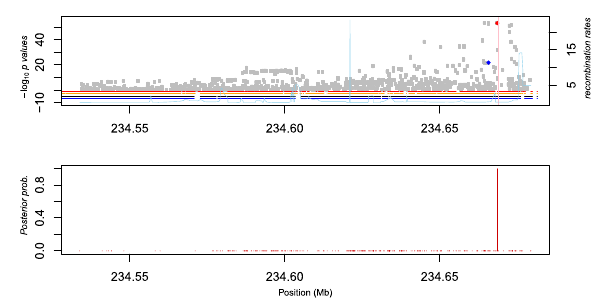
Fig. 2 (Top) UGT1A1 regional association plot. The x -axis represents position in Mb and the y -axis represents − log 10 p values. Sky-blue lines represent recombination rates (cM/Mb) from the 1000 Genomes Project. LD blocks are shown using horizontal lines: red lines for Africans (AADM), orange for African Americans (HUFS), black for CEU from the 1000 Genomes Project, and blue for CHB from the 1000 Genomes Project. The red dot represents rs887829 and the blue dot represents rs10929302. The pink vertical line represents the position of rs3064744 (not present in these data). (Bottom) posterior inclusion probabilities based on fi ne mapping. The red vertical line represents the posterior inclusion probability of rs887829.